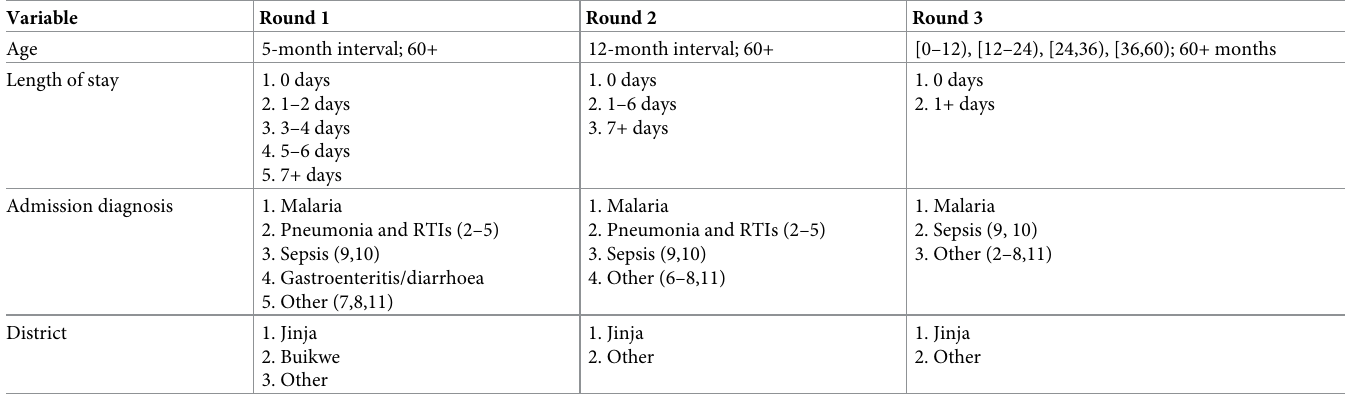
Table 5. Generalization hierarchies for categorical quasi-identifiers.